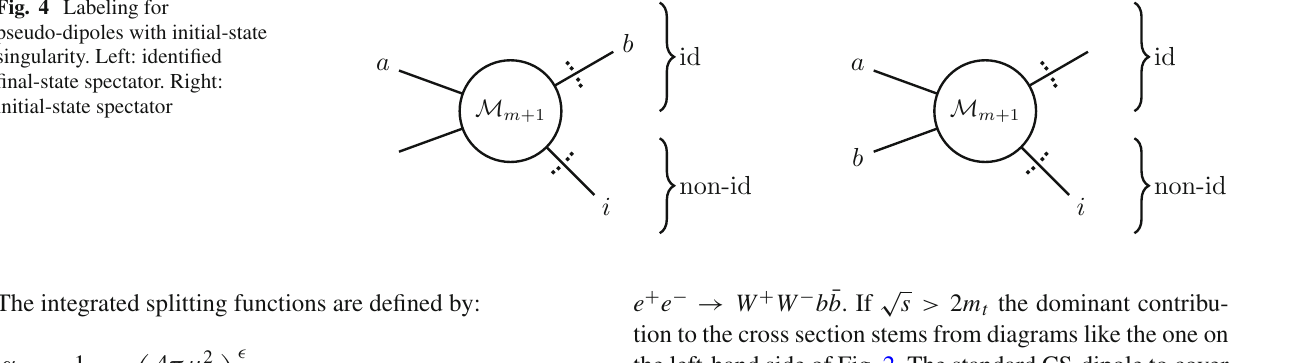
Fig. 4 Labeling for pseudo-dipoles with initial-state singularity. Left: identified final-state spectator. Right: initial-state spectator M m +1